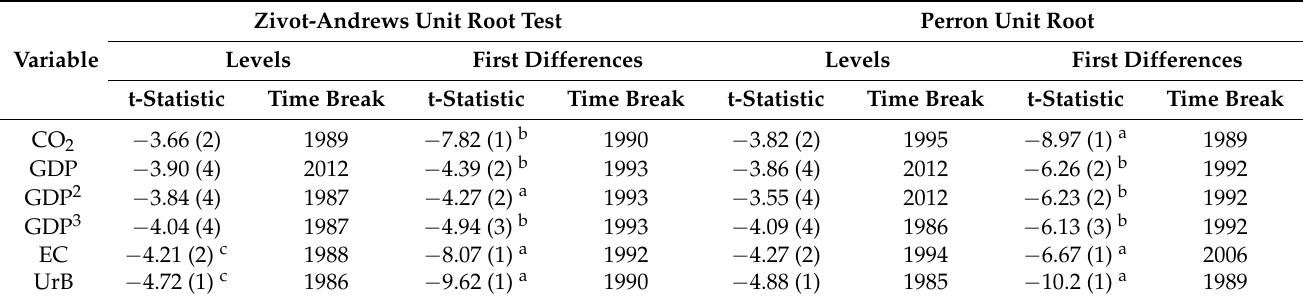
Table 2. Unit root test with structural break: Intercept and time trend